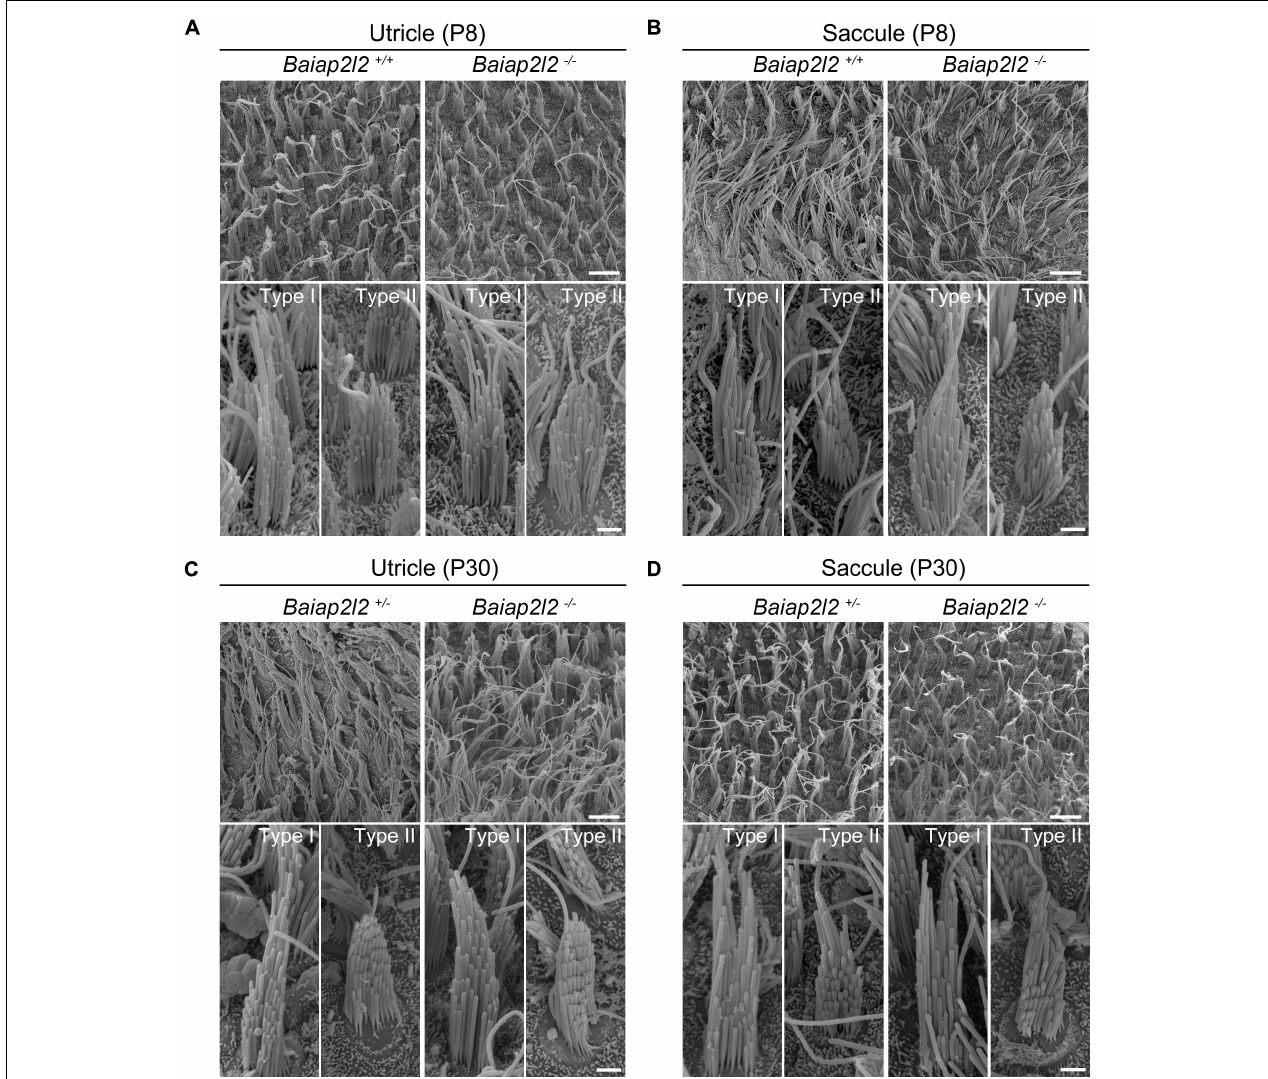
FIGURE 2 | Stereocilia morphology is unaffected in VHCs of Baiap2l2 knockout mice. SEM was performed to examine the stereocilia morphology of P8 utricle (A) , P8 saccule (B) , P30 utricle (C) , and P30 saccule (D) in mice of different genotypes as indicated. In each panel, low-magnification images and high magnification images of type I and II VHCs are shown at the top and bottom, respectively. Scale bar, 5 µ m (in low-magnification images) and 1 µ m (in high-magnification